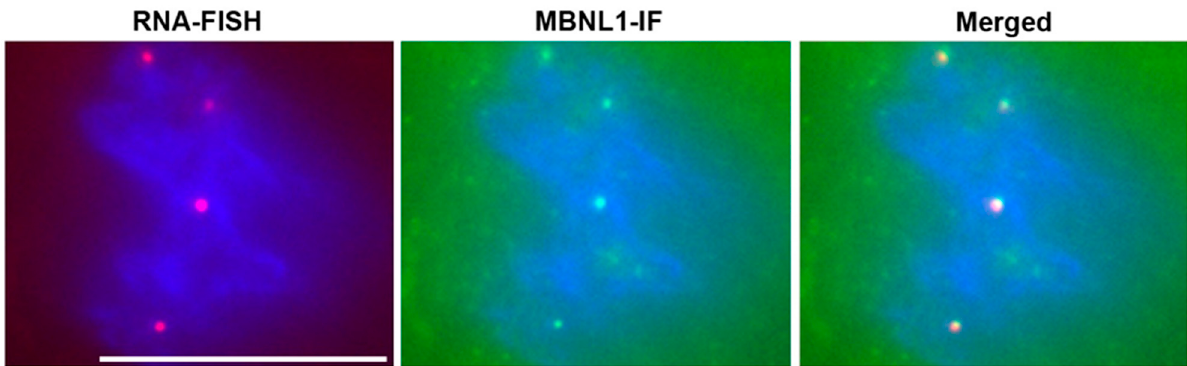
Figure 2. RNA Foci in DM1 Cardiomyocytes. RNA-FISH (RNA fluorescence in-situ hybridization) with a CY3 labeled (CAG) 10 probe detects nuclear foci of mutant DMPK mRNA (red dots). Immunofluorescence microscopy for MBNL1 (MBNL1-IF) shows sequestration of MBNL1 (green dots). Merged image shows co-localization of RNA foci with MBNL1. Nuclei are stained blue with DAPI. Scale bar is 10 µm.